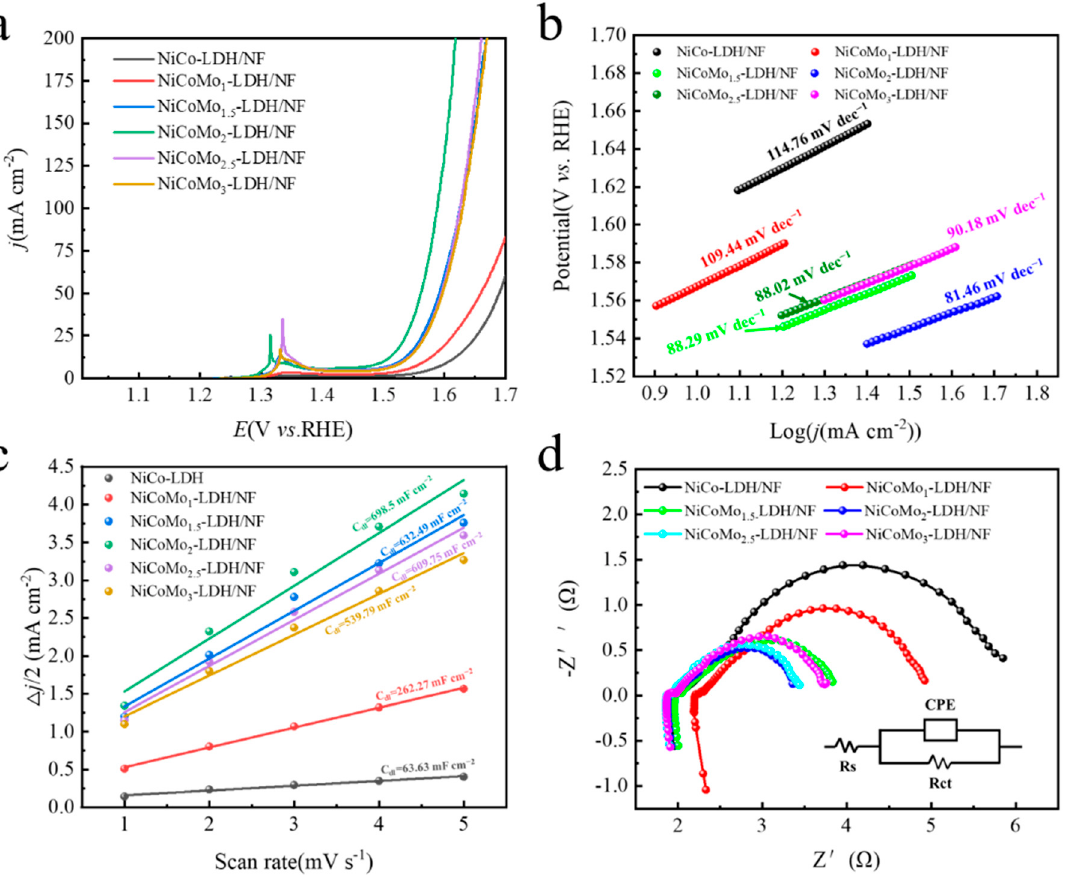
Figure 6. Polarization curves of Mo-doped electrode catalysts. ( a ) LSV curves of NiCoMo-LDH/NF in O 2 -saturated 1.0 M KOH solution at a scan rate of 5 mV s − 1 , ( b ) Tafel plot (overpotential vs. log current) derived from the corresponding polarization curves, ( c ) Plots showing the extraction of the double-layer capacitances allow the estimation of the electrochemically active surface area (ECSA), and ( d ) Nyquist plots recorded at overpotential of 1.56 V vs RHE.